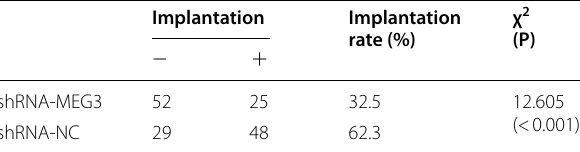
Table 3 Embryo implantation rate of shRNA-MEG3 group and shRNA-NC group